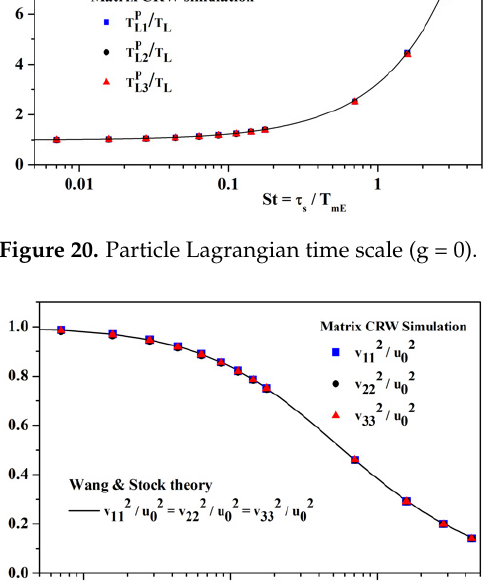
Figure 22. Particle dispersion coefficient (g = 0). 4.3.2. Matrix Method with Gravity (g ≠ 0) Figures 23–25 yield the numerical results obtained with the proposed Lagrangian model. The whole of the numerical results is again compared with the theory developed by Wang and Stock. In Figure 25, the analytical and calculated long time dispersion par- ticle’s coefficients )( ∞ i p D decrease with the Stokes number St in free-fall direction (direc- tion 3) as well as in the two directions orthogonal to the free-fall direction (directions 1 and 2). The agreement between the numerical simulations and the theoretical expressions is very good and the effect of crossing trajectories and continuity effects is clearly seen.